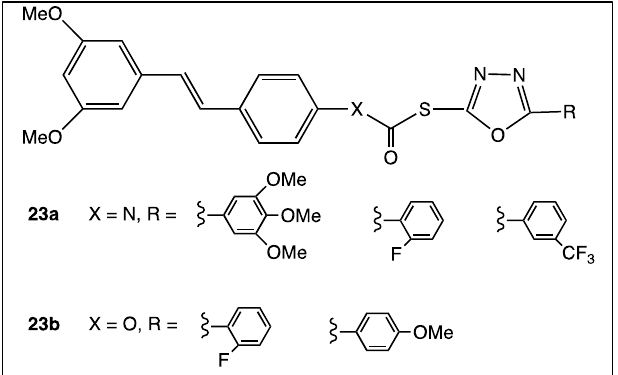
Figure 12 . Structure of resveratrol-oxadiazole hybrid compounds 23a – b.